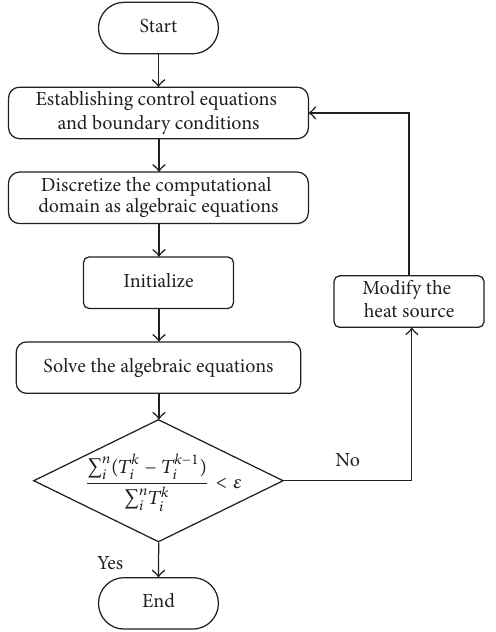
Figure 5: Procedure for the correction of axial heat transfer.